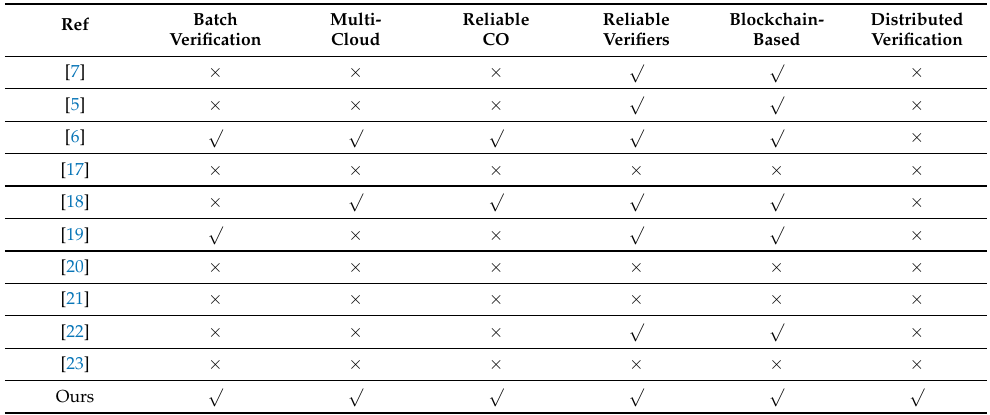
Table 6. Properties requirements